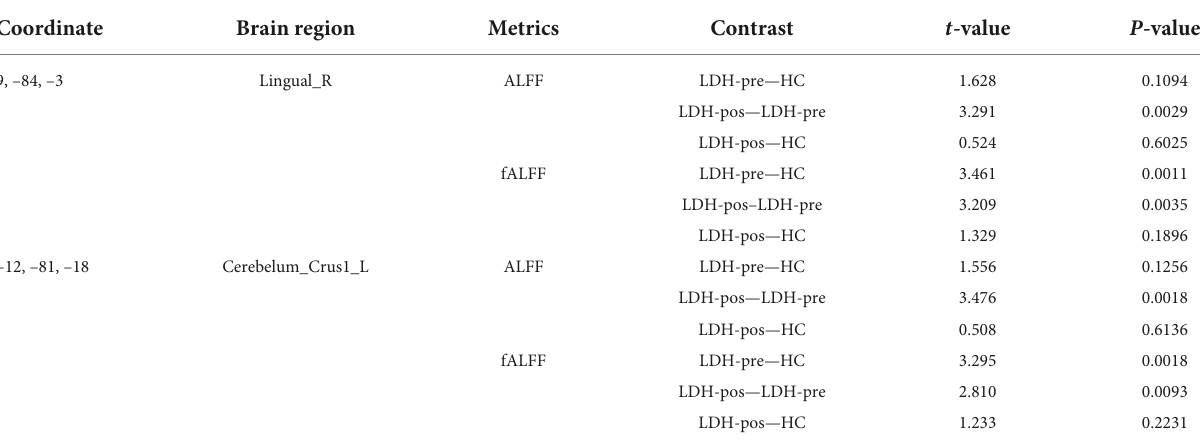
TABLE 3 Group differences in ALFF and fALFF in conventional